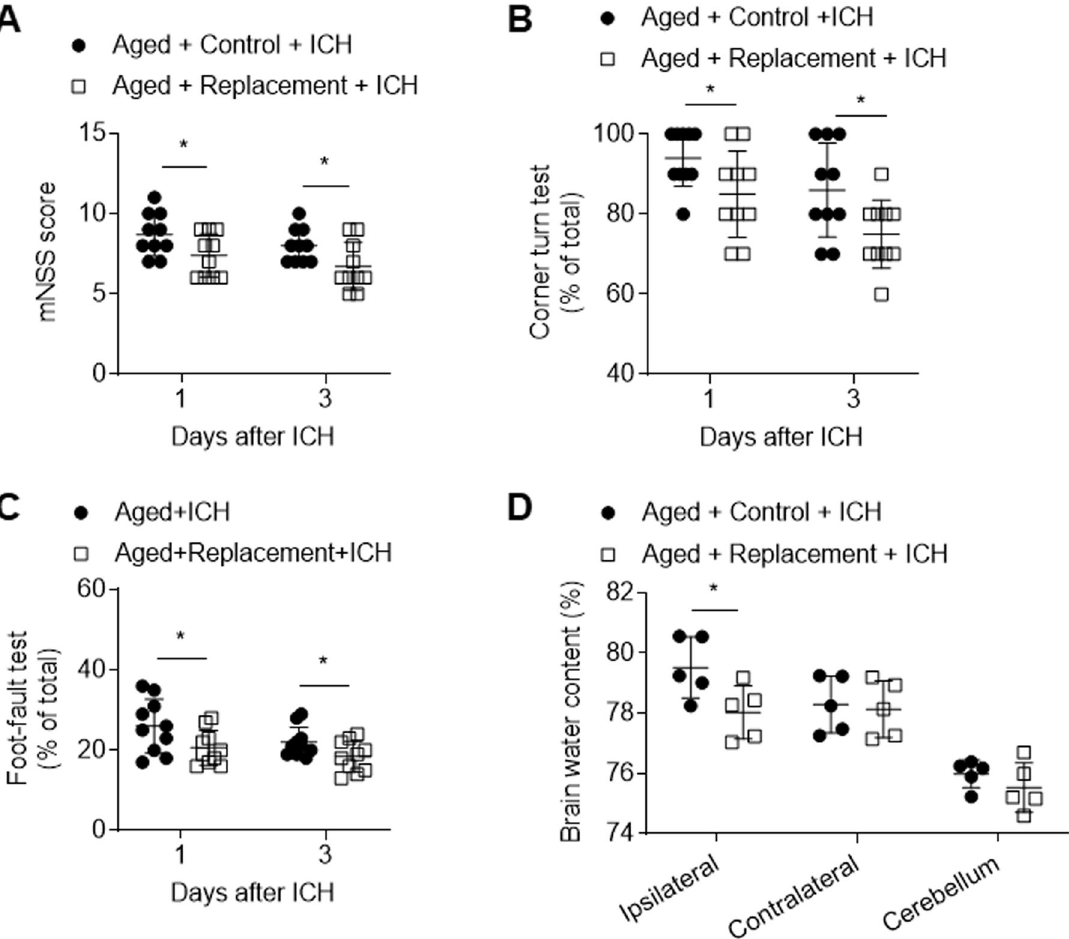
Fig. 2 Effects of microglial replacement on neurological de fi cits and brain water content in the aged mice following ICH. ICH was induced in mice by injection of collagenase. A – C Summarized results showing neurological assessment (mNSS score, corner-turning test, and foot-fault test) of indicated groups of mice. n = 10 per group. D Brain water content in groups of mice receiving indicated treatments at day 3 after ICH. n = 5 per group. Data are presented as mean ± SD. * p <